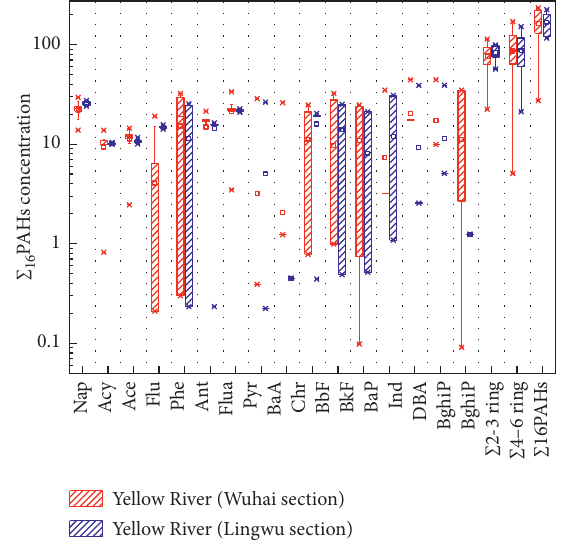
Figure 2: Concentrations of PAHs in surface water from Wuhai and Lingwu sections of the Yellow River.